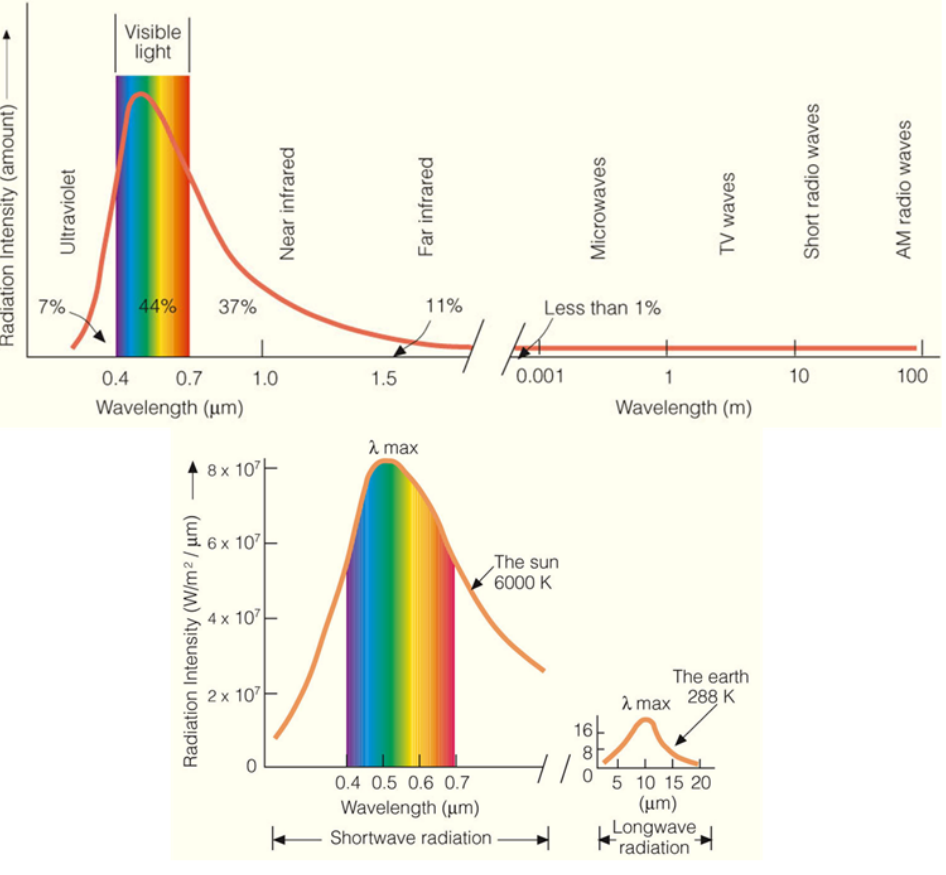
Figure 4. Electromagnetic spectrum of the Sun [17].